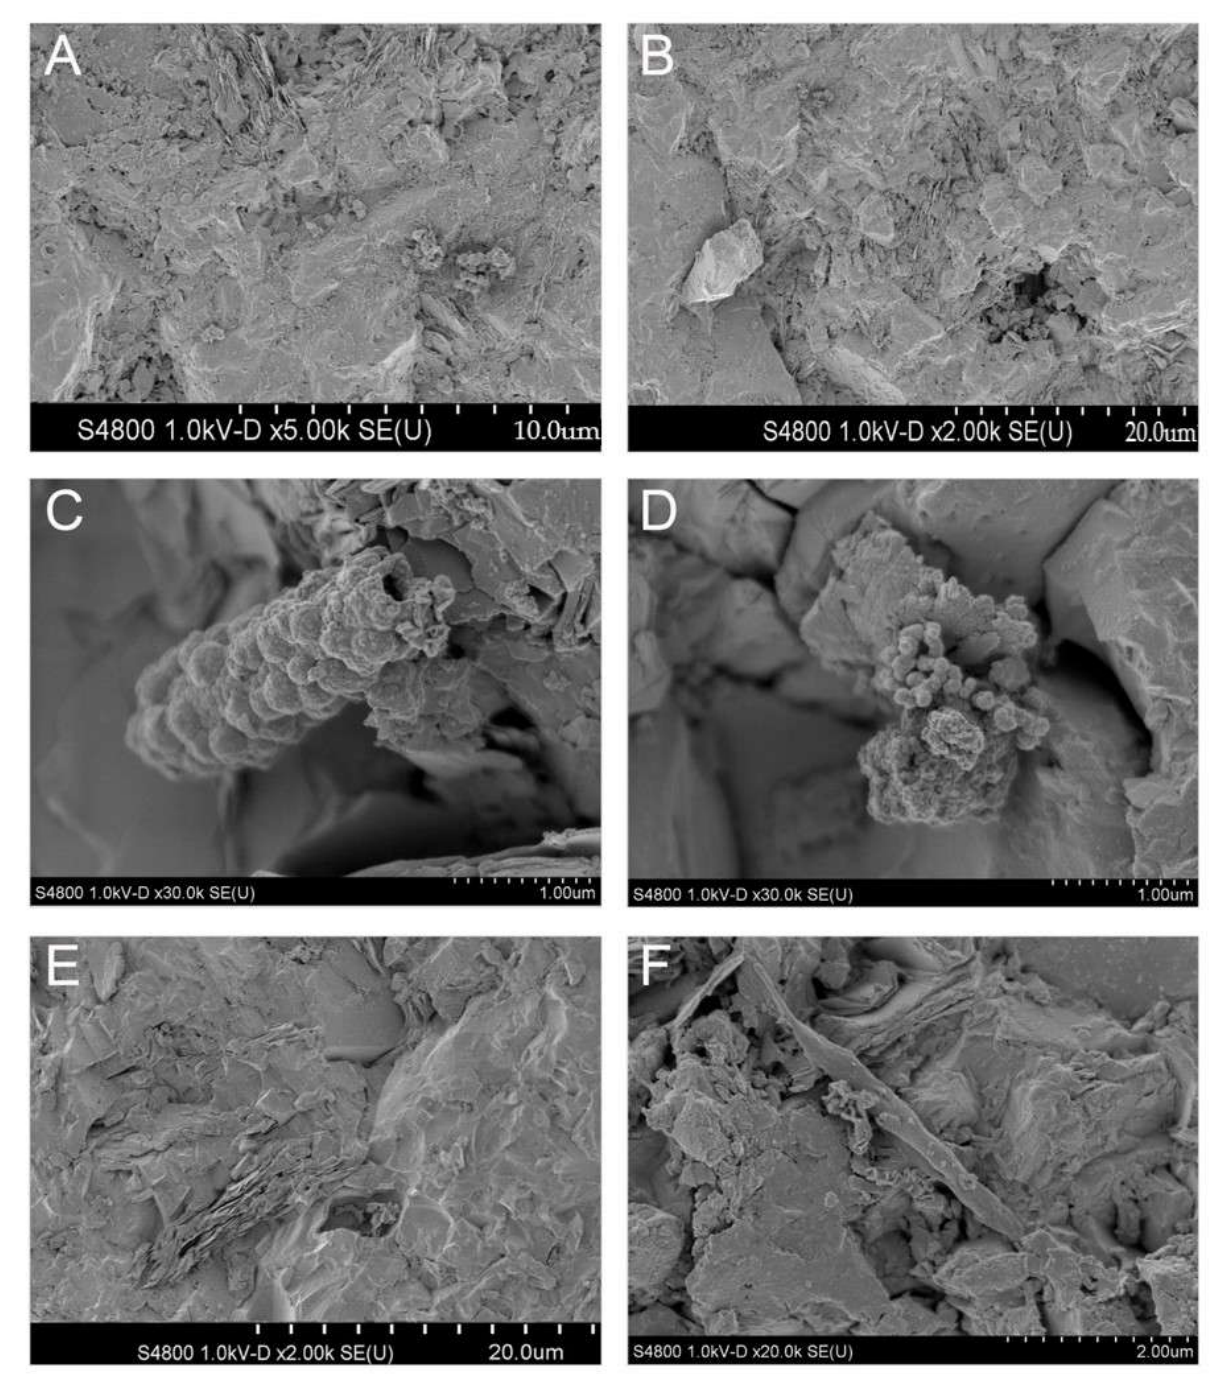
Figure 2. SEM analysis of the in situ incubated mica schist surfaces from the closed trap model ( A , B ) and open trap model ( C – F ) from the depth of 500 m. Each figure has a scale at the bottom for size reference (um = µ m). ( A ) Various potential partly dehydrated microbial cell structures, on the left potential coccoid cells, and on the right cell-like clusters. ( B , E ) Microbial cell-like structure in the potentially microbially formed pit, ( C ) potential mineralized structure, ( D ) nano-scale precipitates, ( F ) structure resembling a large stalked bacterium or fungal